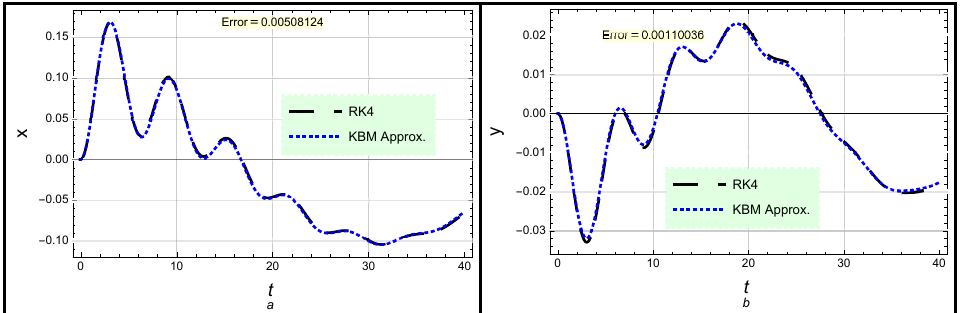
Fig. 2 Figure 2. Both the analytic approximation (45) using the KBM method and the RK4 approximation to the i.v.p. (6) for ( a ) the real and ( b ) imaginary components ( x , y ) are considered.